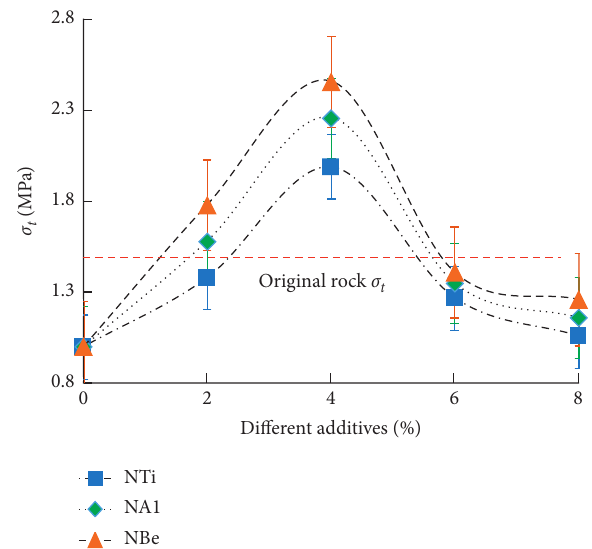
Figure 8: Effects of nanoadditives on uniaxial compressive strength of similar